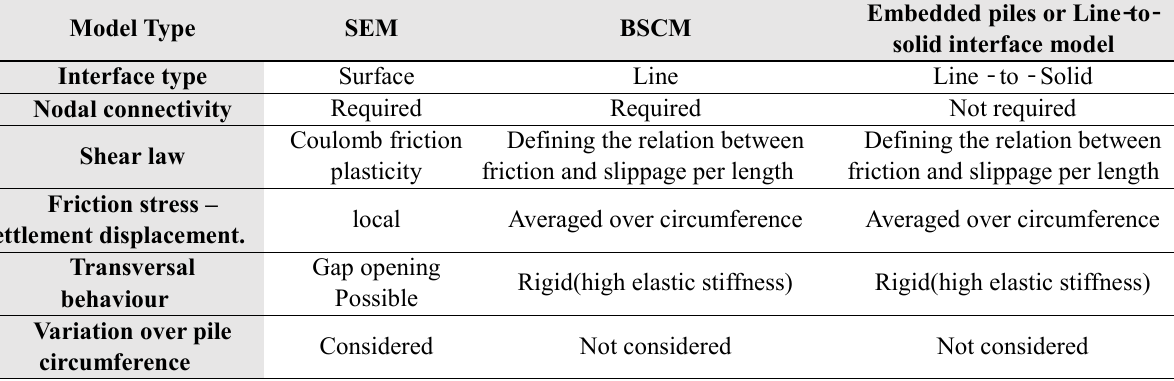
Comparison between three kinds of models for side friction